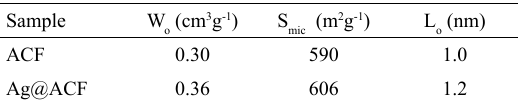
textural properties with similar W and a L of about 1.0 nm. c that the chemical procedure used o to incorporate silver particles on the fiber surface is "soft"